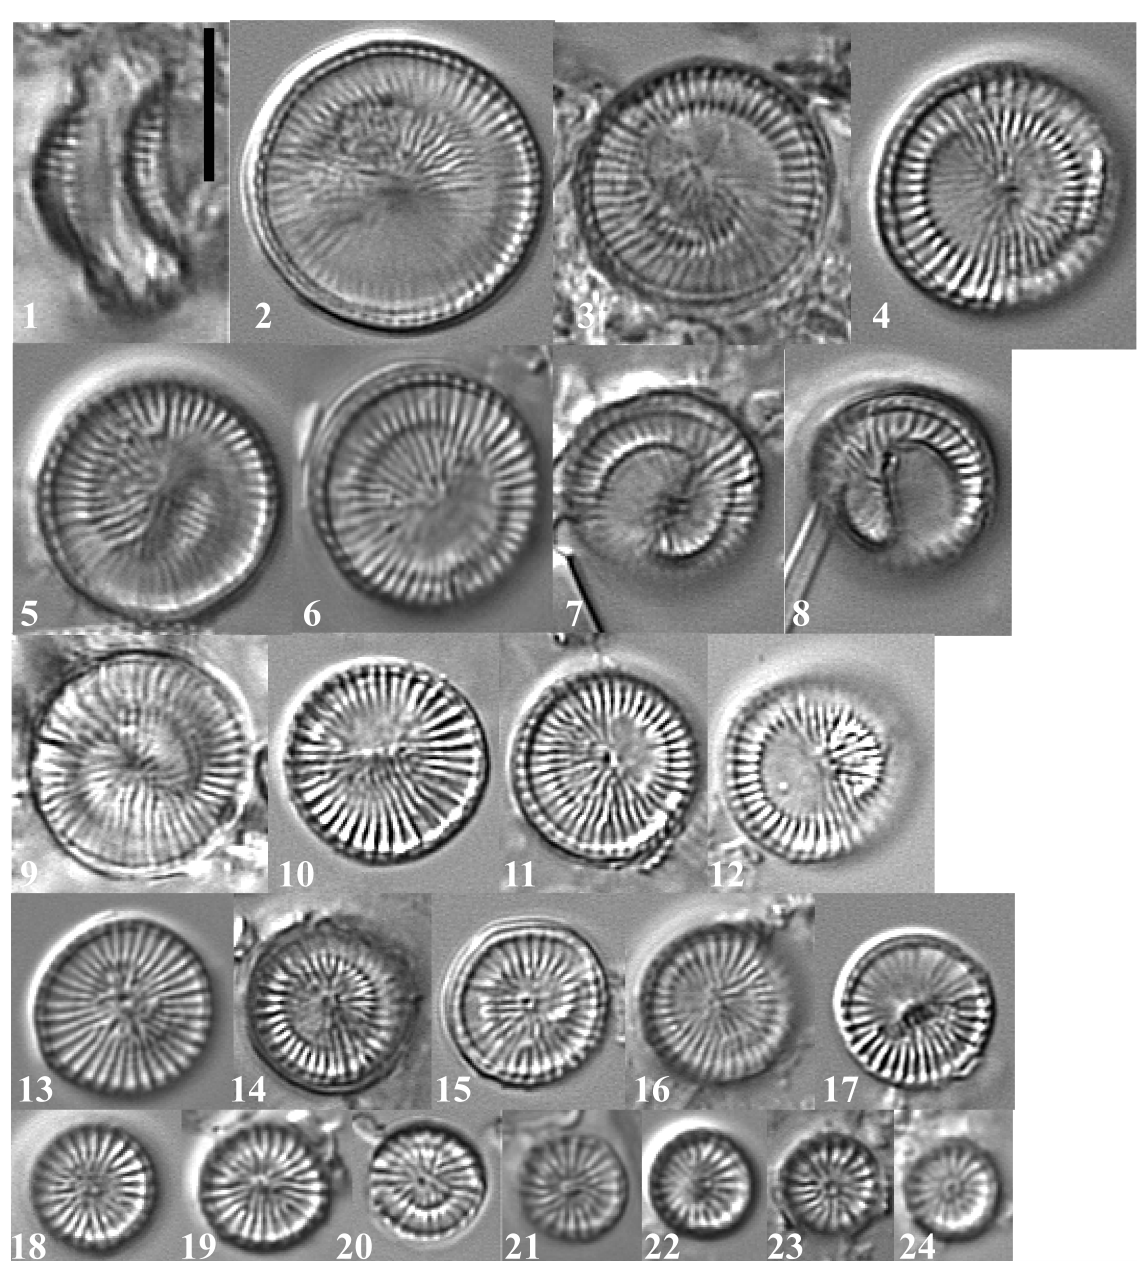
Figs 1–24 . Type material of fossil lacustrine diatom Cyclocostis rolfii Paillès gen. et sp. nov., Lake Petén- Itzá (Guatemala); LM girdle view (1) and valve views (2–24). 4 . Holotype (MNHN, slide PC0608731). 7–8 . Valve surface strongly tangentially undulated, forming an S shape. Scale bar = 10